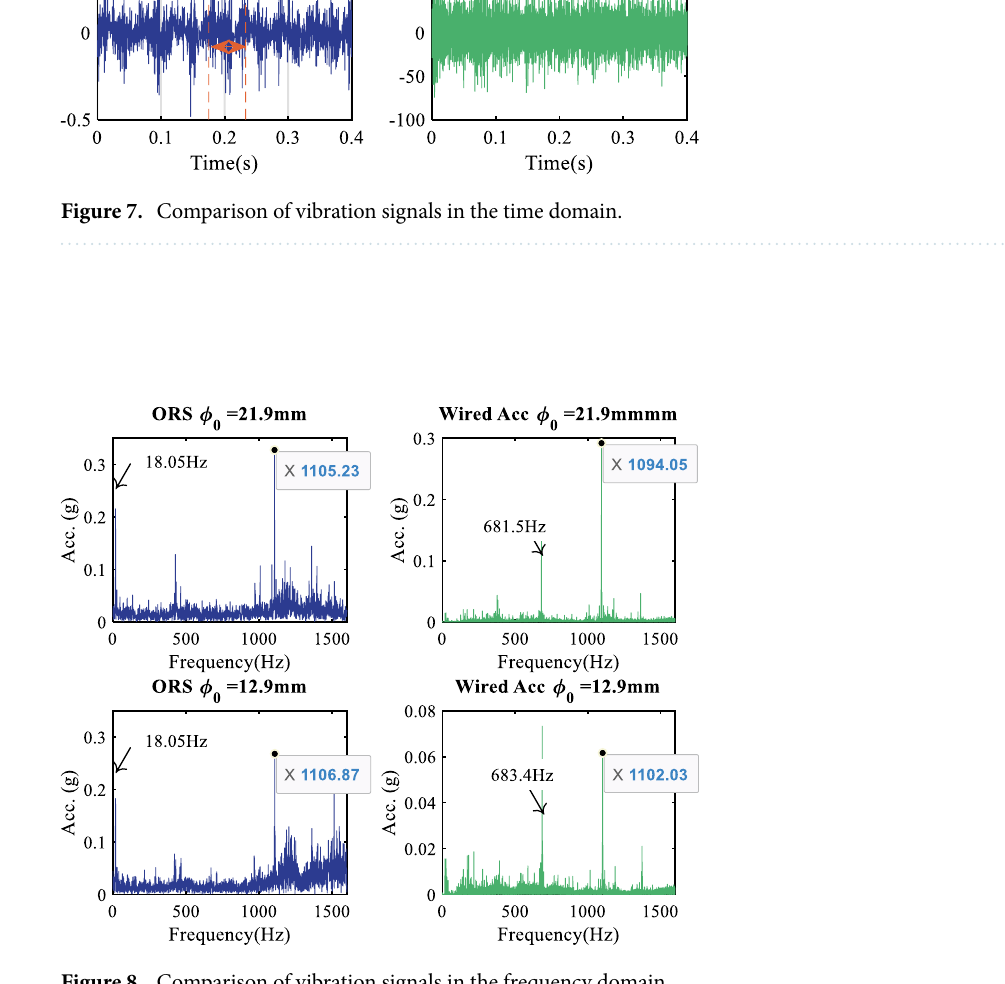
Figure 8. Comparison of vibration signals in the frequency